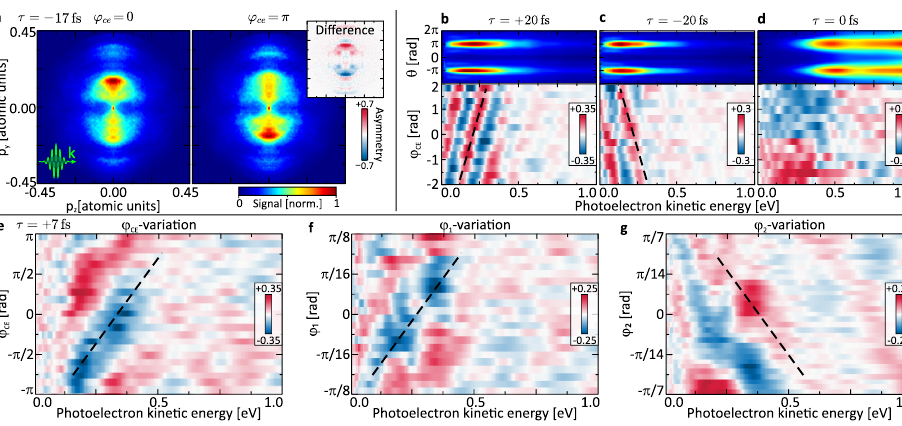
Figure 2. VMI images from time-delayed bichromatic (7 ω :8 ω ) photoionization of xenon atoms show a pronounced CEP-sensitive lateral asymmetry up to 70% [6] (a). Photoelectron asymmetry maps as a function of the kinetic energy and the CEP ϕ ce for di ff erent temporal delays τ between both colors [6] in (b)-(d). In (e)-(g): Photoelectron asymmetry maps generated by variation of the CEP ϕ ce (e), the absolute phase ϕ 1 of the low-frequency (f) and the absolute phase ϕ 2 of the high-frequency field